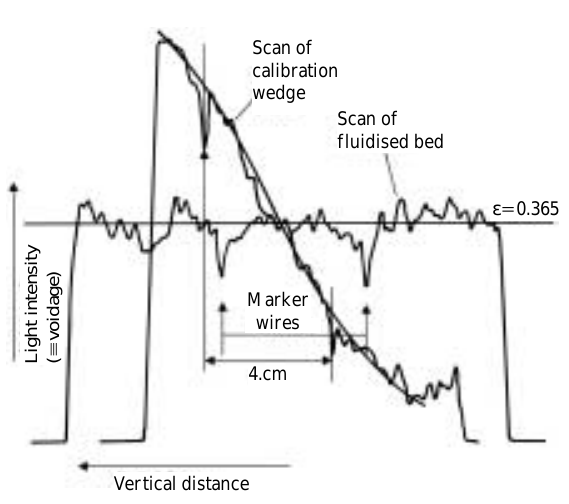
Fig. 3 Microdensitometer scan of an X-ray film and a calibrating wedge [6]